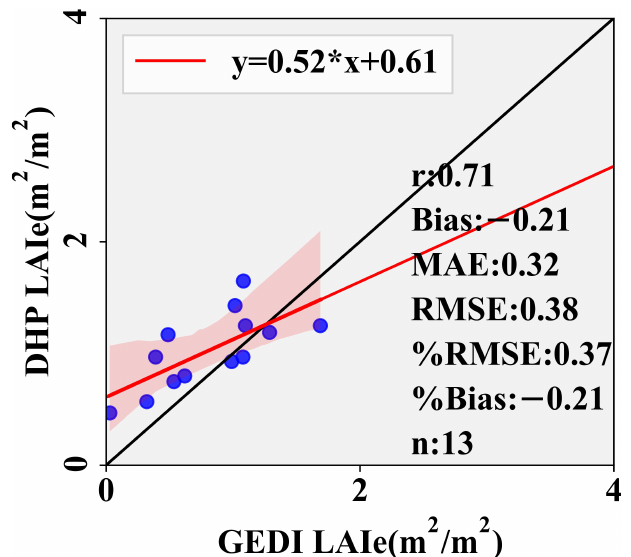
Figure 3. Comparison of LAIe between GEDI and DHP images. The black and red solid lines are the 1:1 line and regression line,